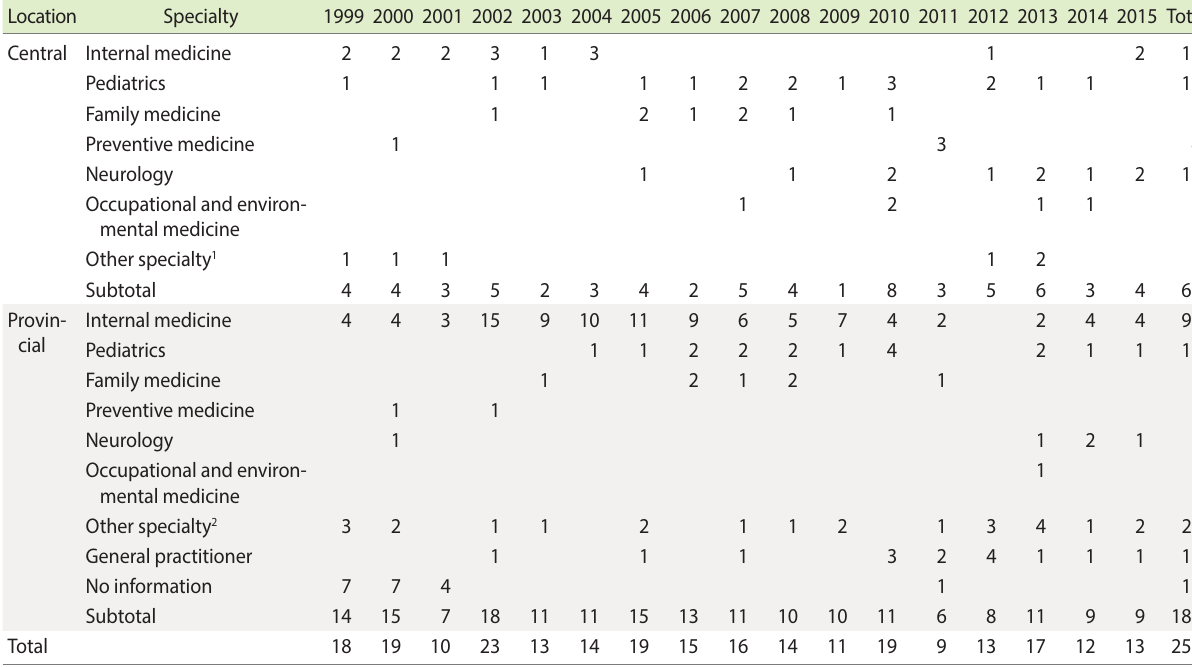
Table 1. Epidemic Intelligence Service officers’ specialties of Korea, 1999-2015